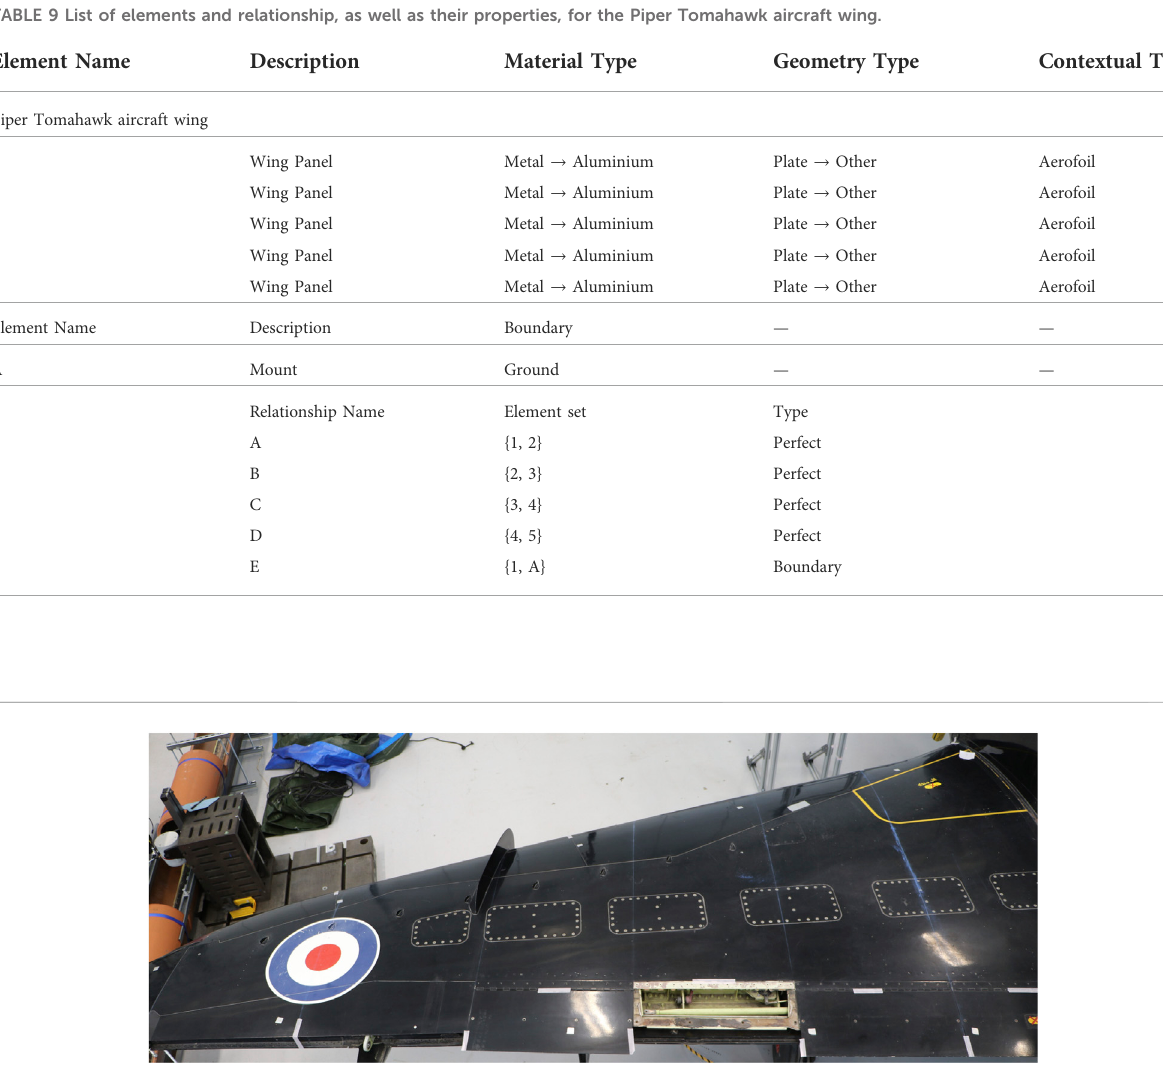
Figure 3 depict how the fuselage and vertical stabilisers were divided into their corresponding elements. The division of the fuselage matches construction markers on the surface of the body; i.e. where there is a visible delimiter via either rivets or welds holding together multiple pieces of sheet metal together. However, the vertical stabilisers have been divided according to curvature changes along the leading edge. The elements and